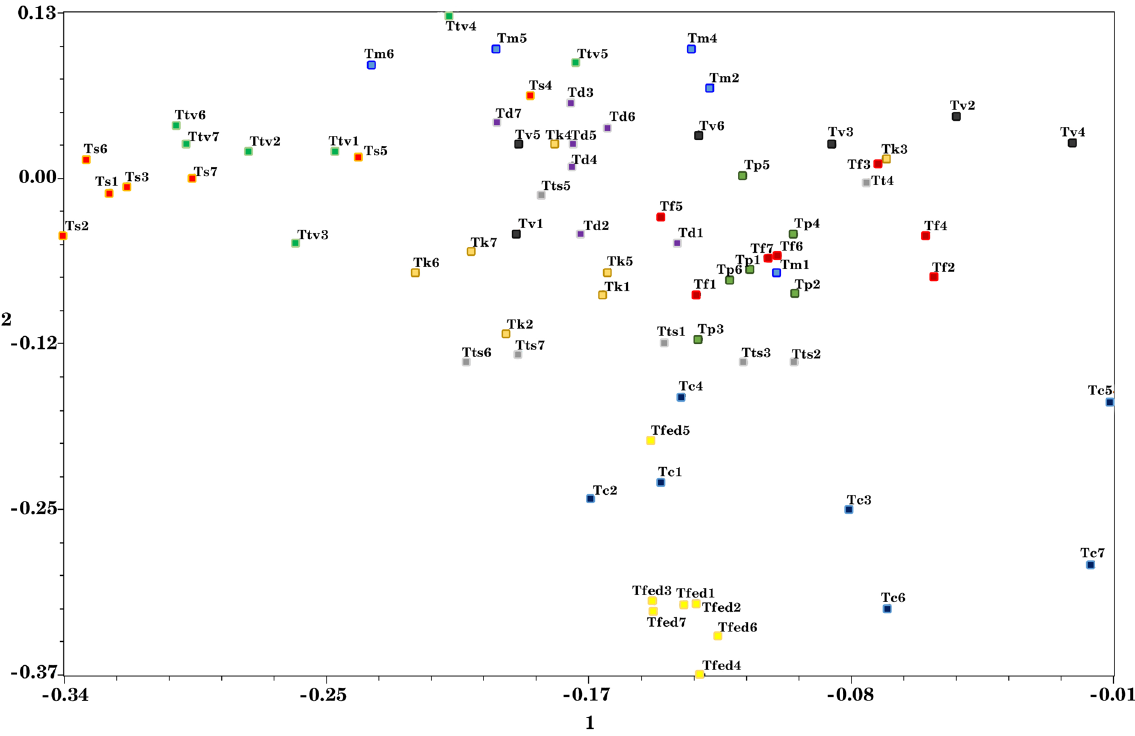
Figure 5. Plot of Thymus samples by principal coordinate analysis using the Jaccard’s similarity coefficients. Footnote: T. migricus ; T. fallax ; T. carmanicus ; T. kotschyanus ; T. pubescens ; T. daenensis , T.